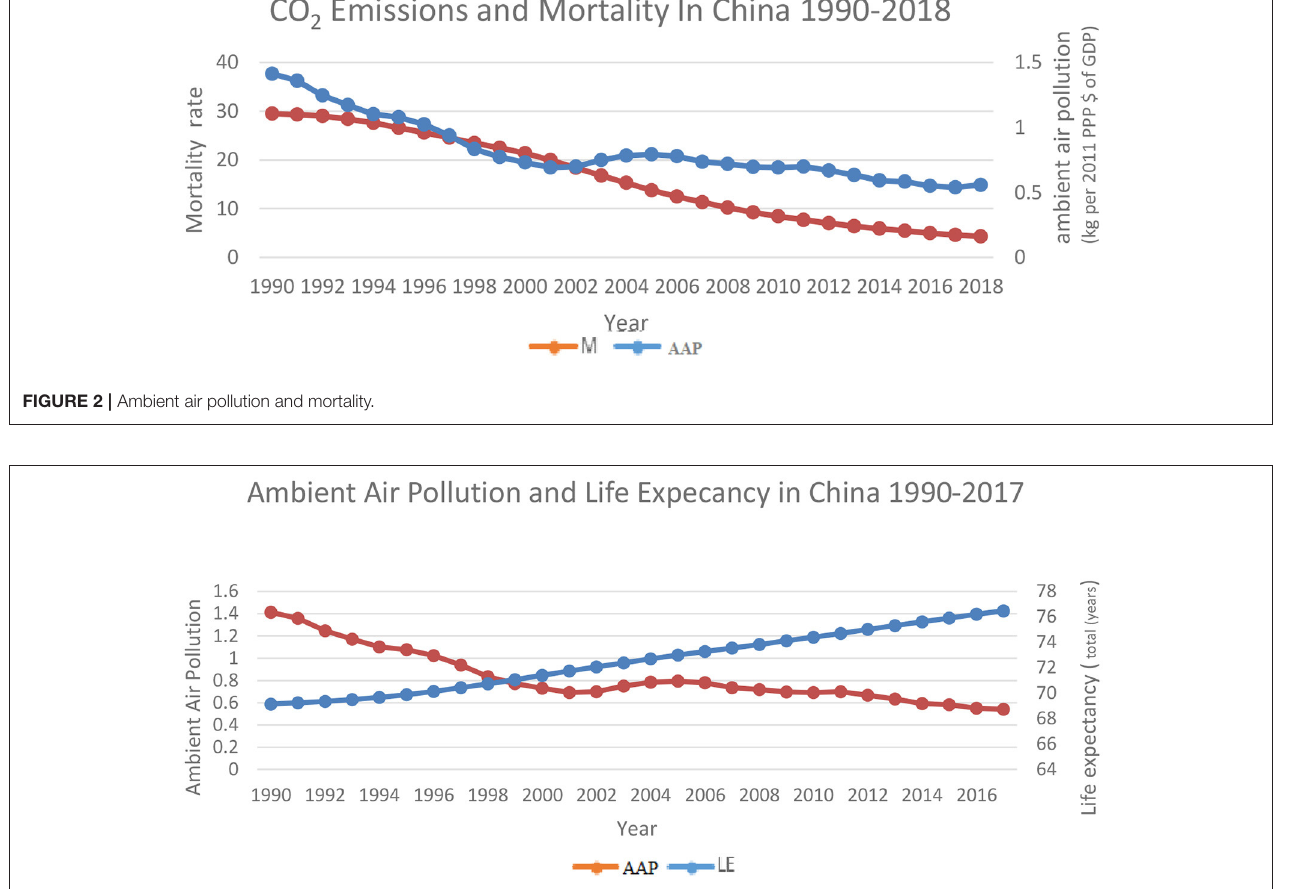
FIGURE 3 | Ambient air pollution and life